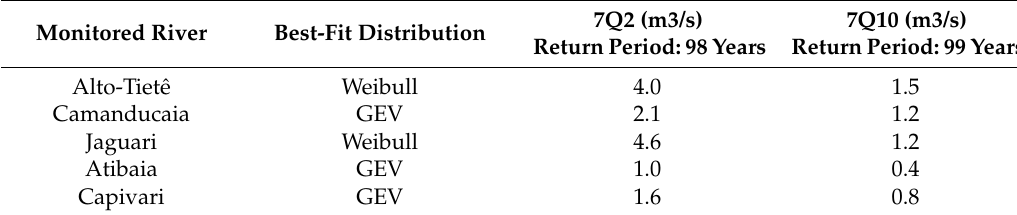
Table 1. Best-fit probability functions of low flow series and extreme low flow thresholds. Monitored River